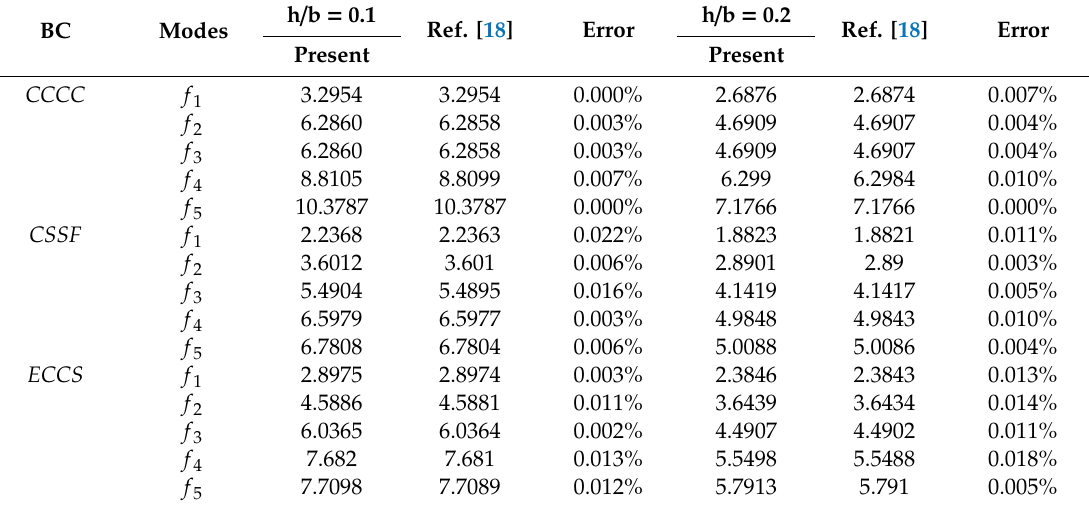
Table 2. Natural frequency parameters for laminated plates with di ff erent